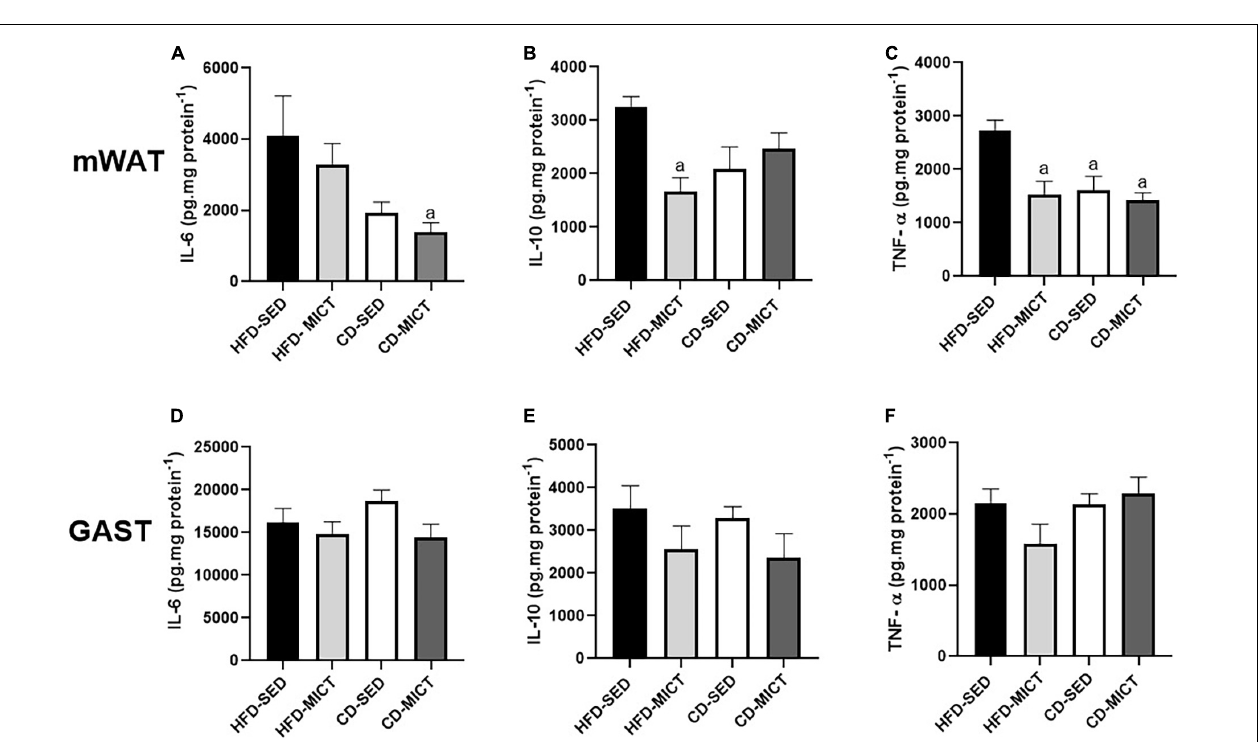
FIGURE 2 | Mesenteric adipose tissue (mWAT) and gastrocnemius muscle (GAST) cytokines concentration. (A,D) IL-6, interleukin-6; (B,E) IL-10, interleukin-10; (C,F) TNF- α , tumor necrosis factor alpha. HFD-SED, high-fat diet sedentary ( n = 5); HFD-MICT, high-fat diet plus MICT ( n = 5); CD-SED, chow diet sedentary ( n = 5); CD-MICT, chow diet plus MICT ( n = 5). Data presented as mean ± SEM ( p < 0.05). a vs.